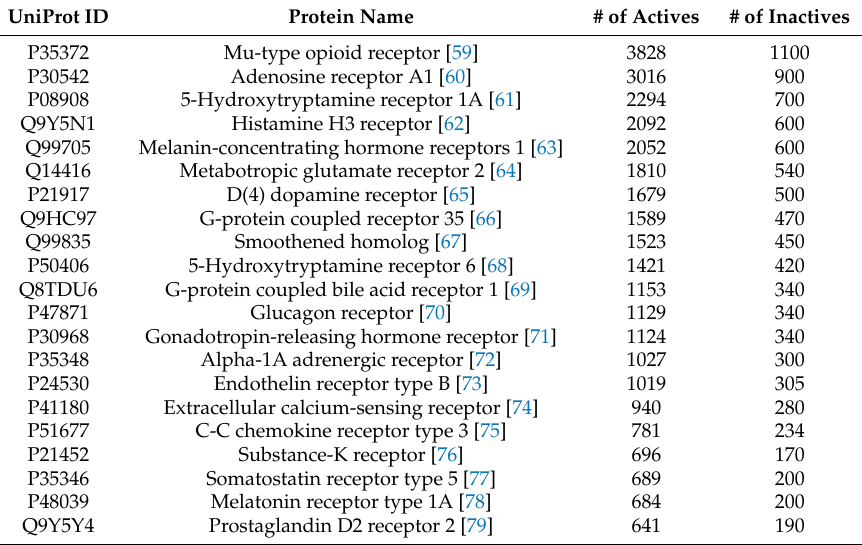
Table 9. Datasets used in the